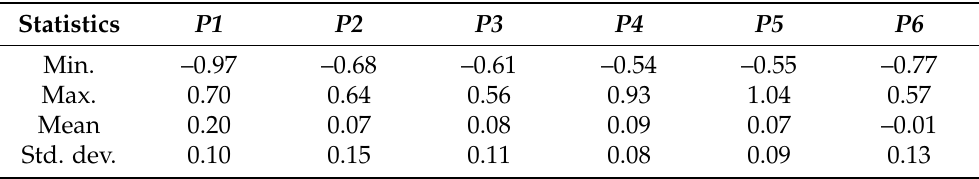
Table 4. Statistical description of dNBR products in different periods ( P